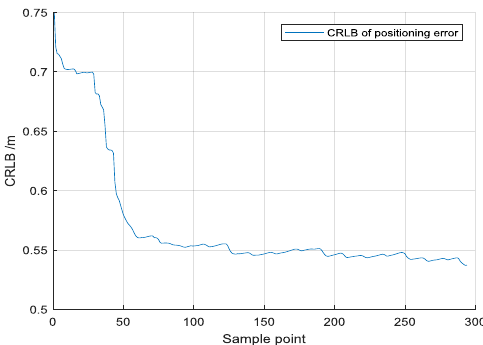
Figure 21. CRLB of positioning error for Route 2.